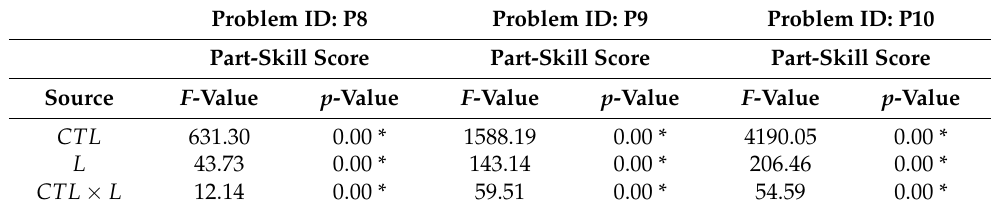
Table 18. Two-way ANOVA results on part-skill score.